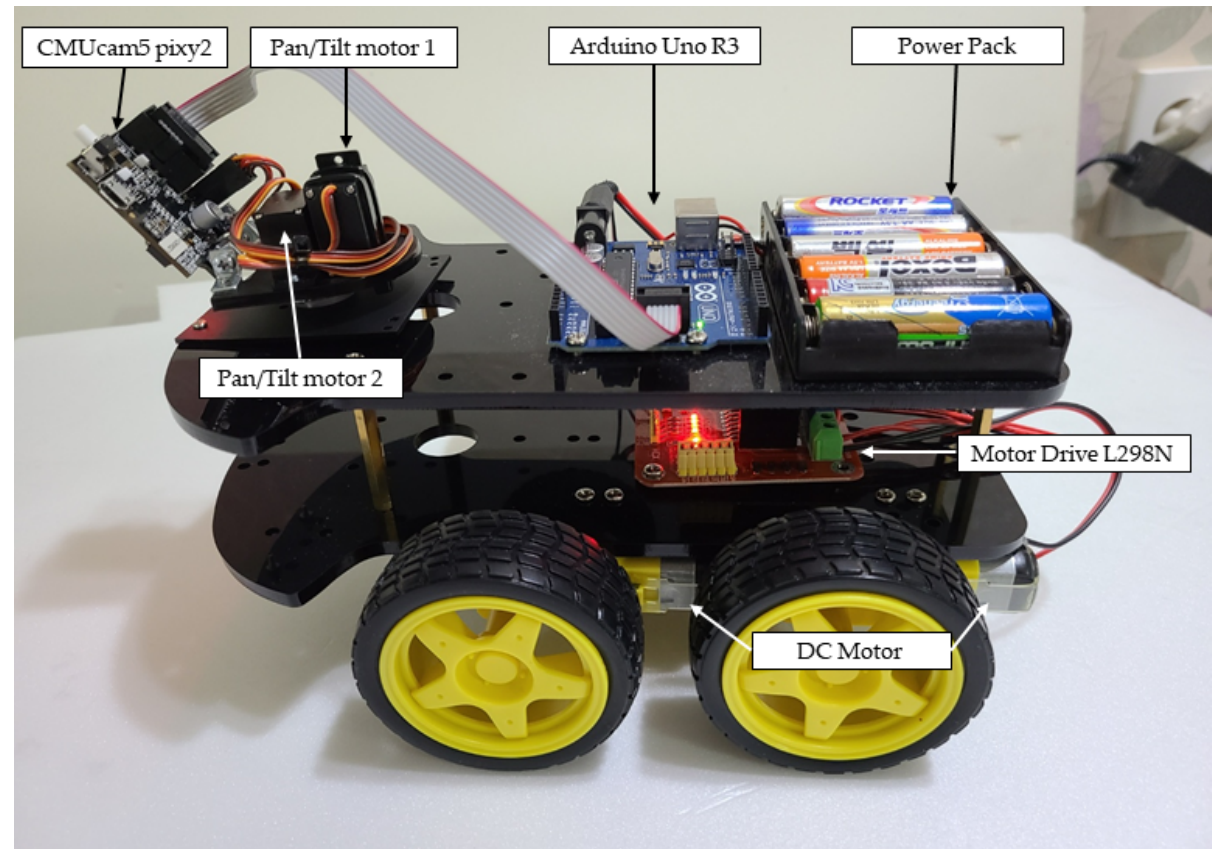
Figure 3. Final hardware design of the AGVA-Robot.